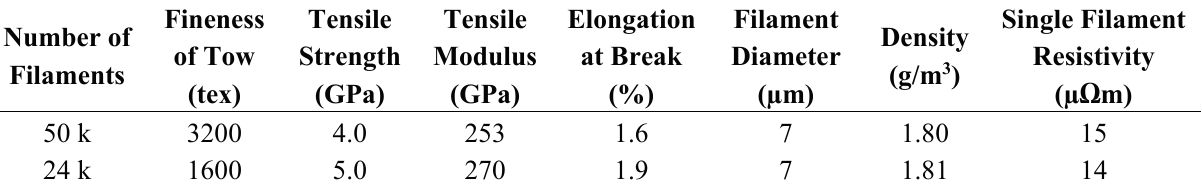
Table 1. Properties of the considered carbon